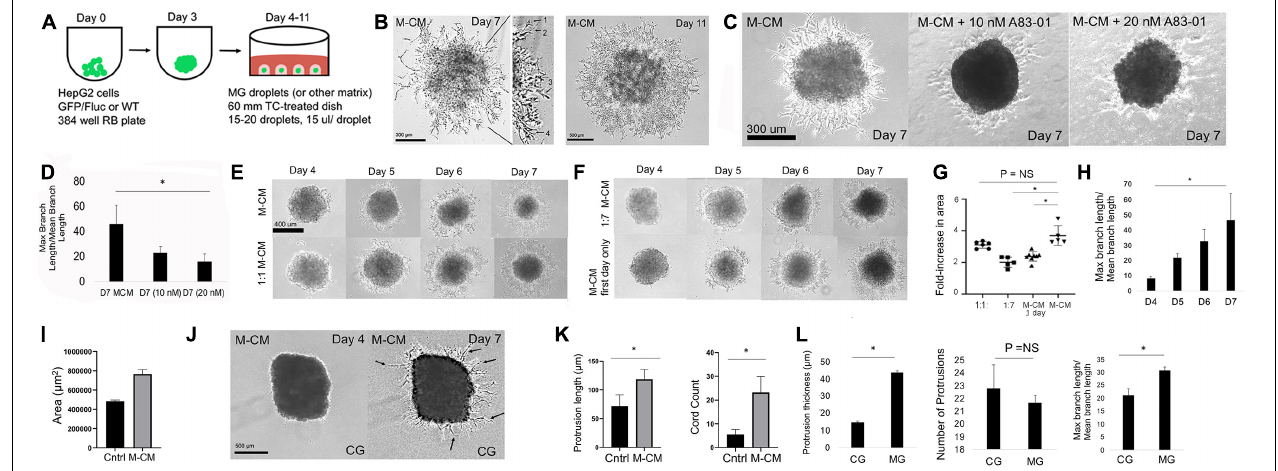
FIGURE 3 | MRC-5-conditioned medium induces 3D collective cell migration within the in vitro liver diverticulum model . (A) Schematic for modeling the LD in MG droplets. HepG2 spheroids are embedded in MG droplets (15 µ l) with 15–20 droplets per dish and cultured in M-CM medium. (B) Phase-contrast images of day 7 (low and high magnification) and day 11 liver spheroid in the MG droplet system cultivated with M-CM. Left: high-magnification view demonstrates various stages/modes of 3D collective migration including the following: (1) filopodia branching, (2) filopodia elongation, (3) cell and nuclear extension (nucleus is visualized), and (4) branches that are interacting. (C) Phase-contrast images on day 7 of HepG2 spheroids in MG exposed to M-CM alone, M-CM with A83-01 (10 nM), and A83-01 (20 nM). (D) Bar graph analysis comparing day 7 M-CM and MCM + A83-01 (20 nM) ( P = 0.047, n = 3). Plotted is mean ± SD. Significance defined as P ≤ 0.05. (E) Phase-contrast images of HepG2 spheroids in MG droplet assay in study of M-CM dilution on days 4–7. Conditions tested were M-CM and 1:1 M-CM. (F) Phase-contrast images HepG2 spheroids in MG droplet assay in study of M-CM dilution on days 4–7. Conditions tested were 1:7 M-CM and M-CM first-day only. For M-CM first-day only, M-CM was added from days 3 to 4, washed gently, and then switched to M-CM. (G) Analysis of MG droplet assay with M-CM. Left, plot of fold change in area across different M-CM dilutions (1:1, 1:7, M-CM 1 day only, and M-CM). Comparison of M-CM with 1:1 condition ( P = 0.15, n = 3 for both conditions), M-CM with 1:7 condition ( P = 0.0056, n = 3 for both conditions), and M-CM with M-CM 1-day-only condition ( P = 0.019, n = 3 for both conditions). (H) Analysis of branching of morphogenesis (max branch length/mean branch length) between days 4 and 7 ( P = 0.047, n = 3). Plotted is mean ± SD. Significance defined as P ≤ 0.05. (I) Bar graph comparing growth area of HepG2 spheroid in MG droplet assay in control (no CM) with M-CM conditions on day 7 of culture ( P = 0.010, n = 3). Plotted is mean ± SD. Significance defined as P ≤ 0.05. (J) Phase-contrast images on days 4 and 7 of HepG2 spheroid in collagen (CG) droplet and M-CM medium. Arrows specify thin filopodia-like extensions into collagen. (K) Bar graph analysis of HepG2 spheroids in CG in control and M-CM conditions comparing protrusion length ( P = 0.012, n = 3) with cord count ( P = 0.007, n = 3). (L) Bar graph analysis in CG and MG conditions comparing protrusion thickness ( P = 0.0000027, n = 3), number of protrusion ( P = NS), and max branch length/mean branch length ( P = 0.010, n = 3). Plotted is mean ± SD. Significance defined as P ≤ 0.05. ∗ is used to denote significance of experimental